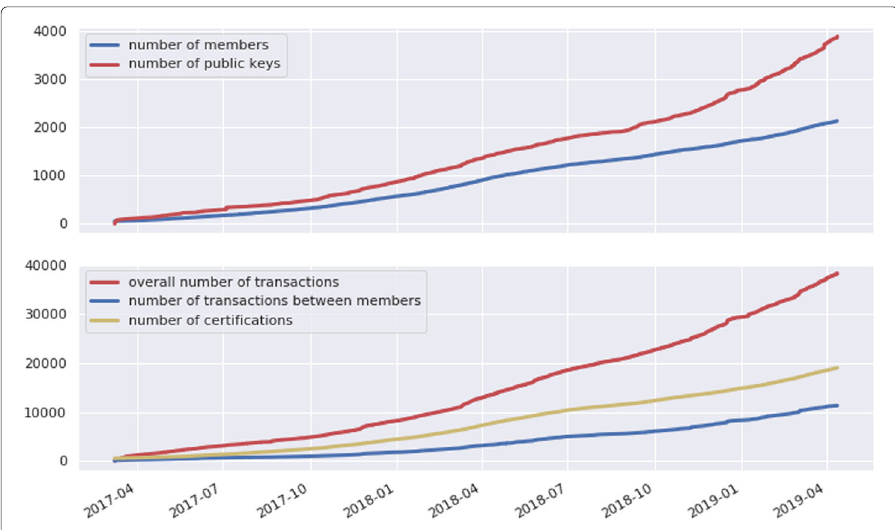
Fig. 1 System growth. Top - Evolution of the number of public keys ( | V | , red curve) and members ( | M | , blue curve) since the currency’s creation in March 2017. Bottom - Evolution of the number of certifications (yellow curve), transactions (red curve) and transactions between members (blue